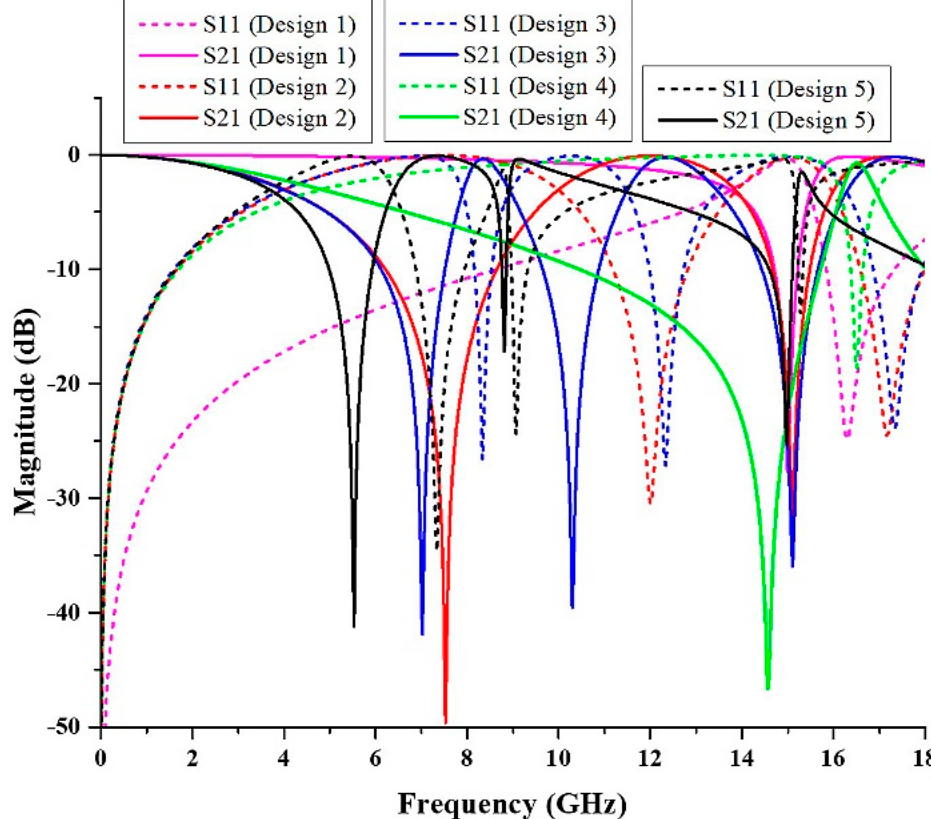
Figure 12. The comparison for the S-parameters of the different design of metamaterials.